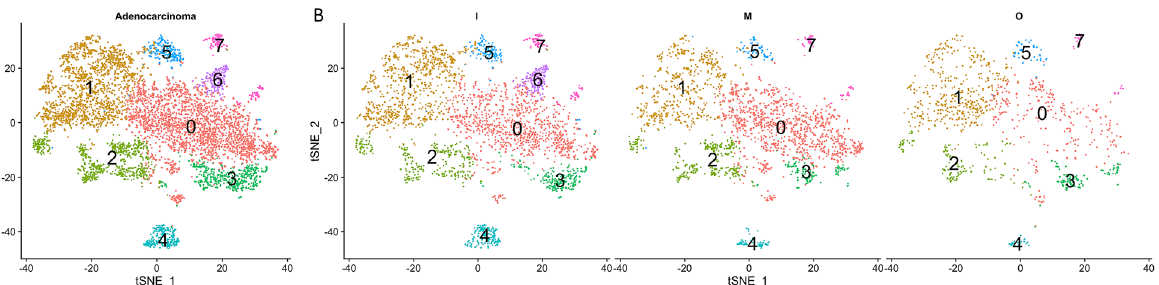
Figure 2. t-distributed stochastic neighbor embedding plots of the eight clusters from Seurat analysis ( A ) and of the eight clusters according to tumor site ( B ). I inner (core), M middle, O outer